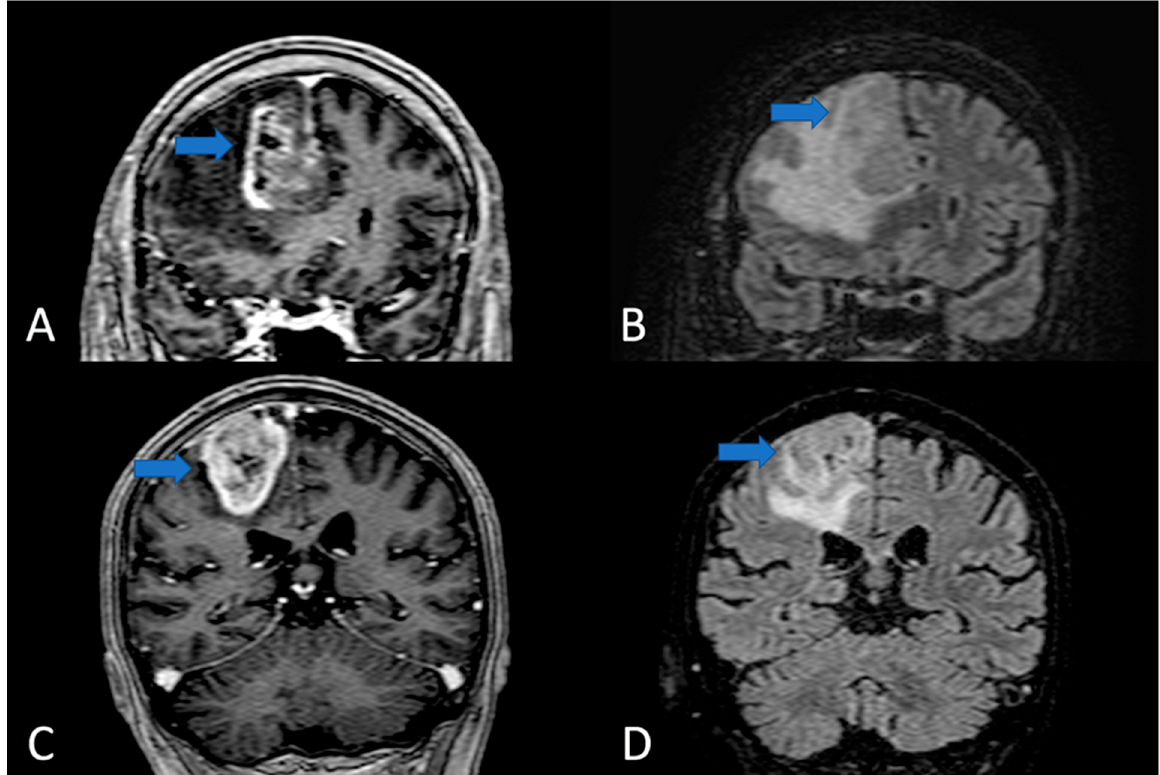
Figure 2. Coronal section of MRI T1 with gadolinium ( A , C ) and FLAIR sequences ( B , D ). In A and B images, the GBM mass located in the subgyral sector developed into superior frontal gyrus/cyngulum. The enhancing nodule is confined in a precise anatomical sector and apparently does not invade the superior frontal sulcus (blue arrow). In ( C , D ), a gyral GBM that is completely confined in the ascending parietal gyrus (the blue arrow shows the spared sulcus delimiting the tumor).